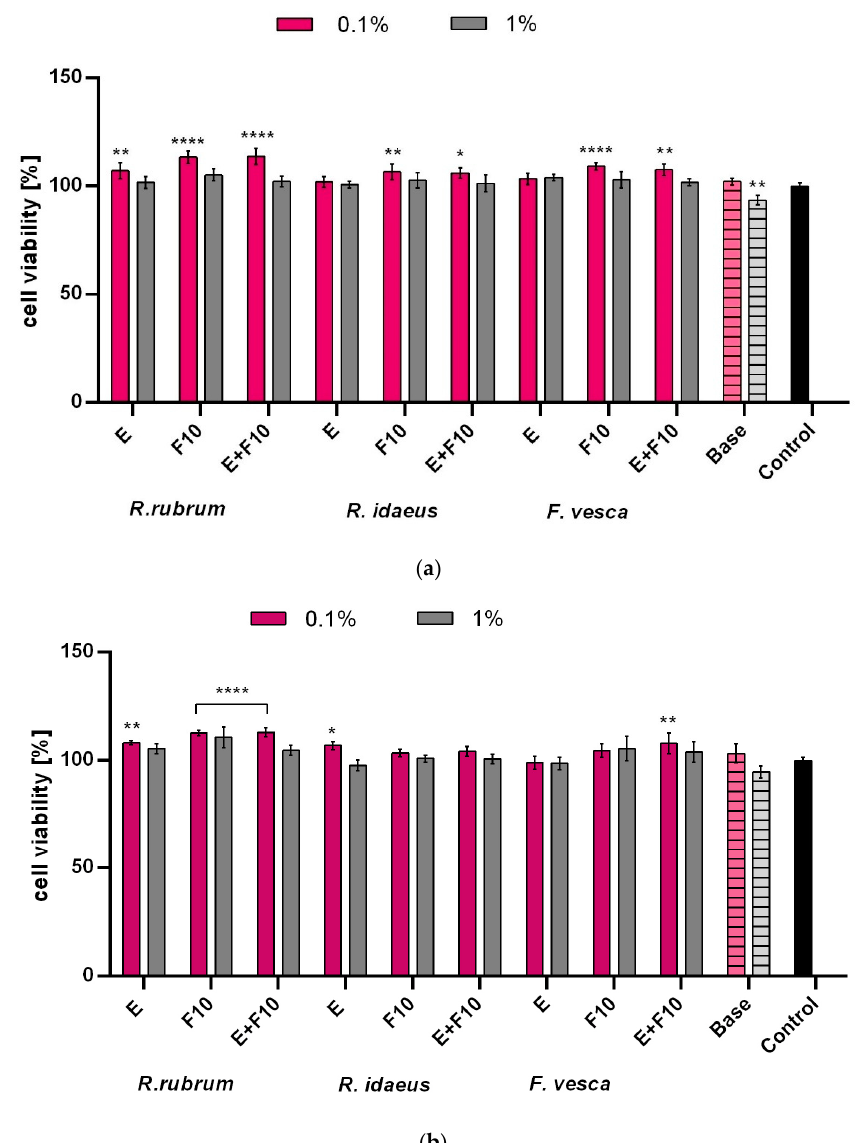
Figure 6. Effect of cosmetic formulation containing R. rubrum, R. idaeus, and F. vesca extracts and ferments (at the dilution of 0.1 and 1%) on Alamar Blue Assay ( a ) and Neutral Red dye uptake ( b ) in cultured keratinocytes (HaCaT) after 4 h of exposure. Data are the mean ± SD of three independent experiments, each consisting of three replicates per test group. **** p < 0.0001, ** p < 0.01, * p < 0.05 compared to control.